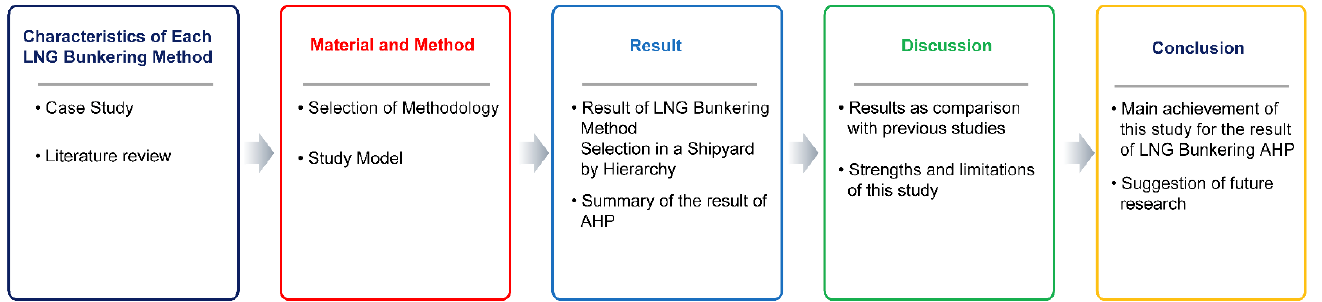
Figure 1. Outline of the research.